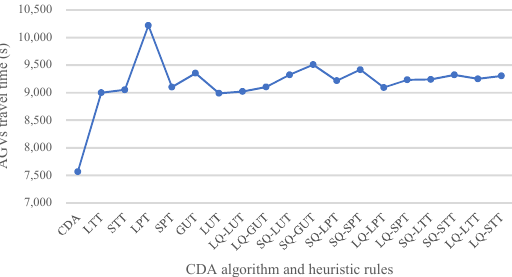
Figure A2. Curve of tasks delay time of CDA algorithm and assignment rules under different cases.